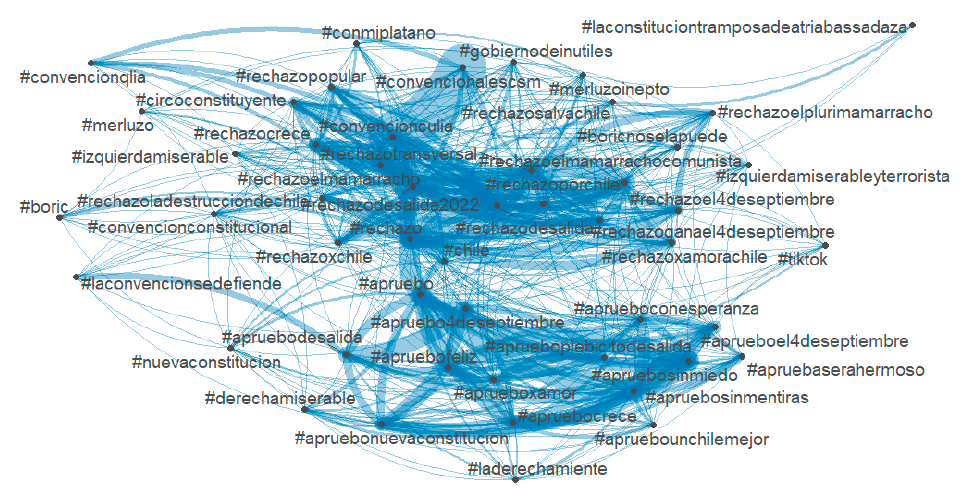
Figure 6. Network of hashtags with hate speech for Vamos por Chile 2022.